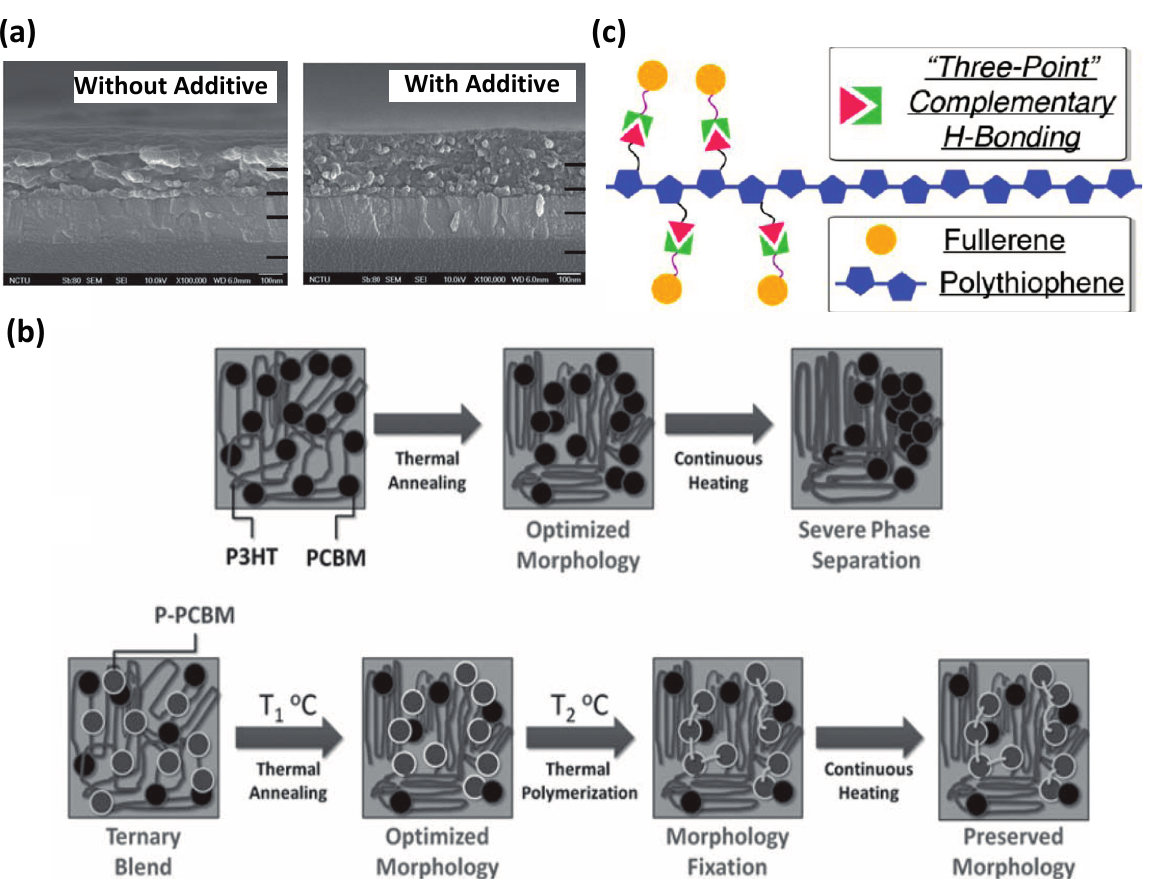
Figure 6. ( a ) SEM cross-sectional images of P3HT/PCBM solar cell device without and with additive: crosslinkable fullerene derivatives, after thermal annealing at 150 °C for 25 h; ( b ) Schematic illustration of the P3HT/PCBM morphological evolutions without and with additives: crosslinkable fullerene derivatives, respectively under thermal treatments and thermal aging; ( c ) Illustration of three-point hydrogen bonding among polythiophene, fullerene and additive. Reprinted with permission from [59] copyright 2011 Wiley; [62] copyright 2013 American Chemical Society.